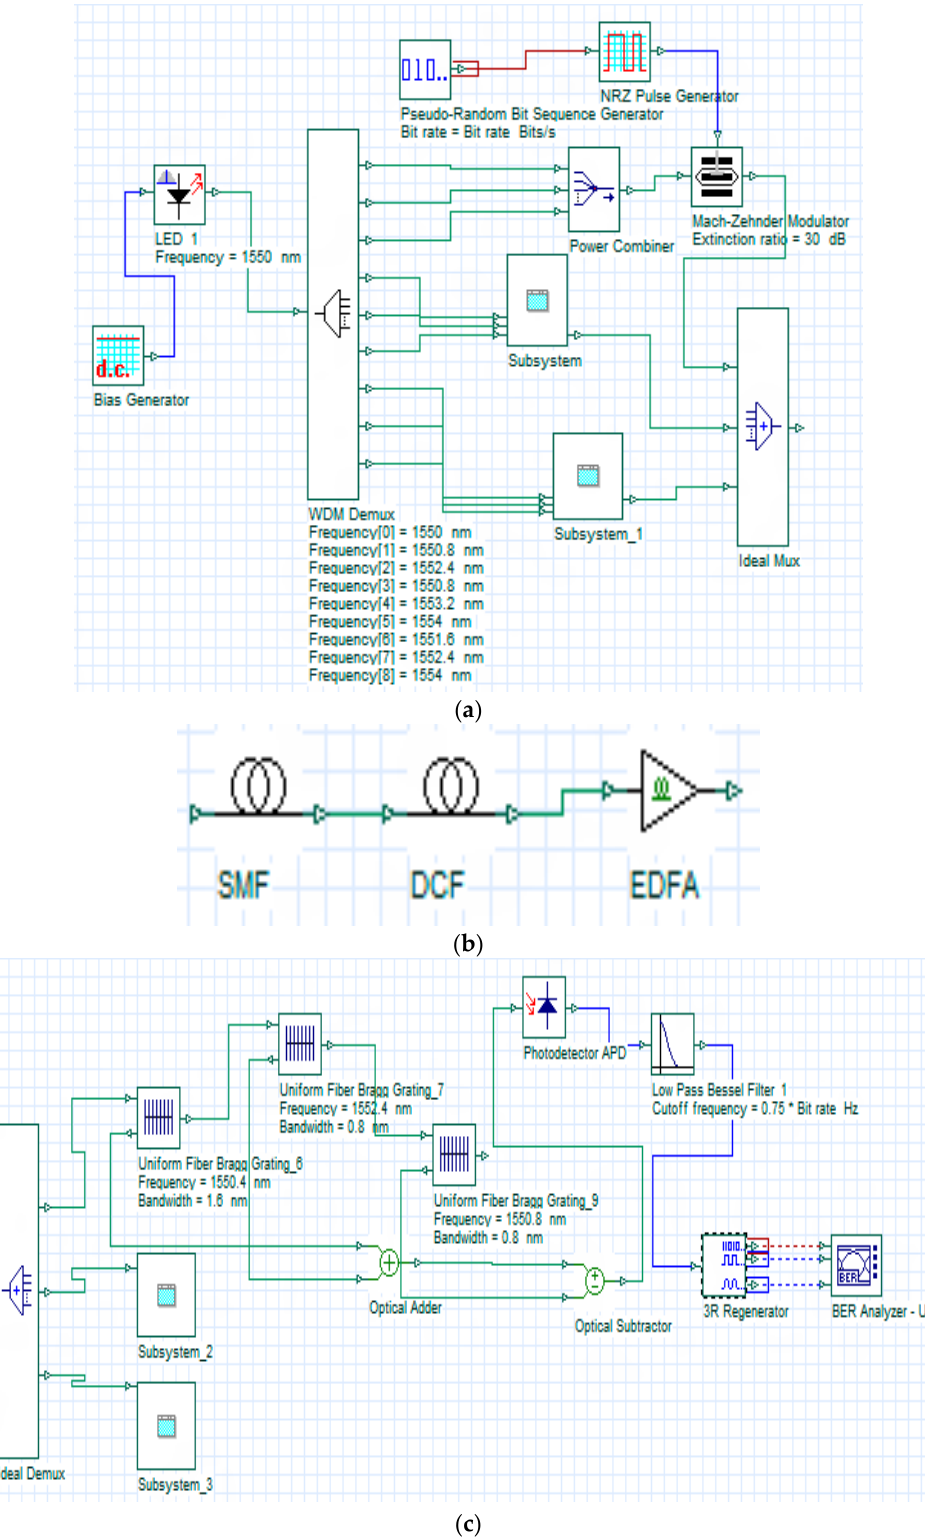
Figure 2. Block diagram of three users of spectral amplitude coding-optical code division multiple access (SAC-OCDMA): ( a ) transmitter using enhanced double weight (EDW) code, ( b ) channel, and ( c ) receiver using EDW code.